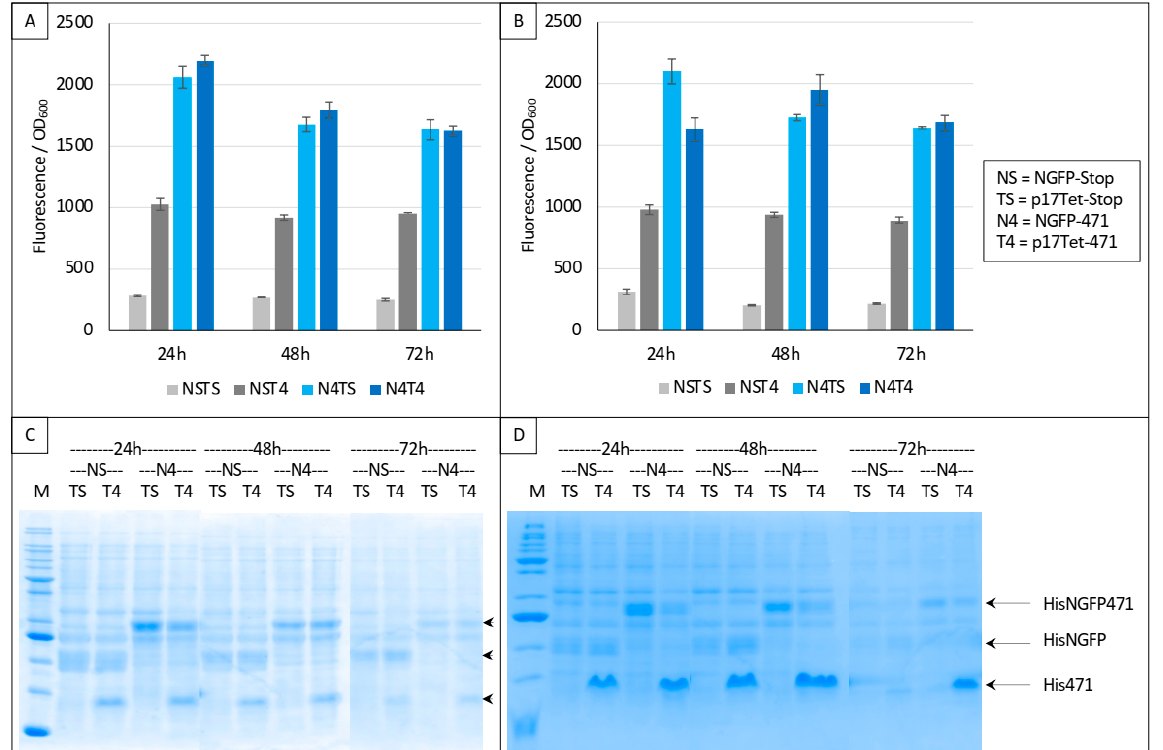
Figure 4. Split-GFP reassembly competition assay using NGFP-471, XD-CGFP, and His-471 as competitor. ( A , B ) Fluorescence data obtained in two independent experiments, each performed in triplicate for 24, 48, or 72 h. NSTS and NST4 are the two negative controls. See main text for a description of NSTS, NST4, N4TS, and N4T4. ( C , D ) SDS-PAGE analysis of ( A , B ), respectively. M, molecular mass markers (200, 150, 100, 85, 60, 50, 40, 30, 25, 20, 15, 10 kDa).